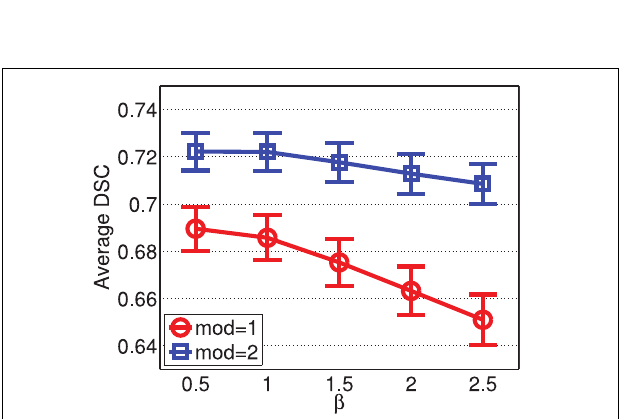
FIGURE 8 | Joint label fusion performance with respect to β (error bars at ± 0.05 standard deviation). Other parameters are set to r p = 2 , r s = 3 , α = 0 . 1.